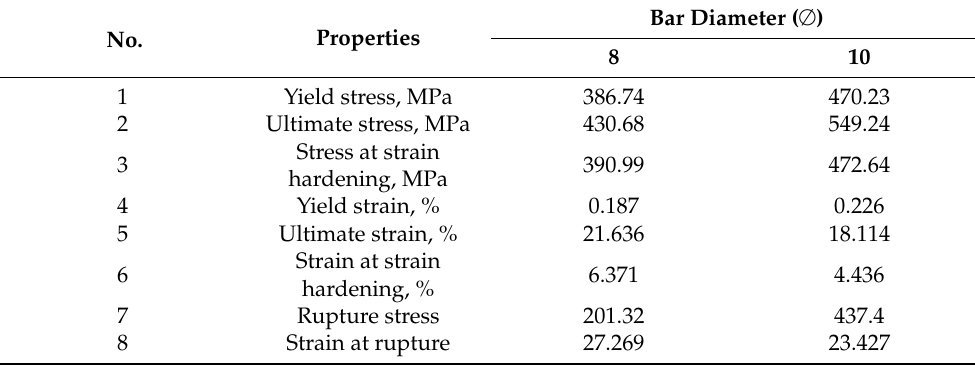
Table 3. Tensile properties of steel